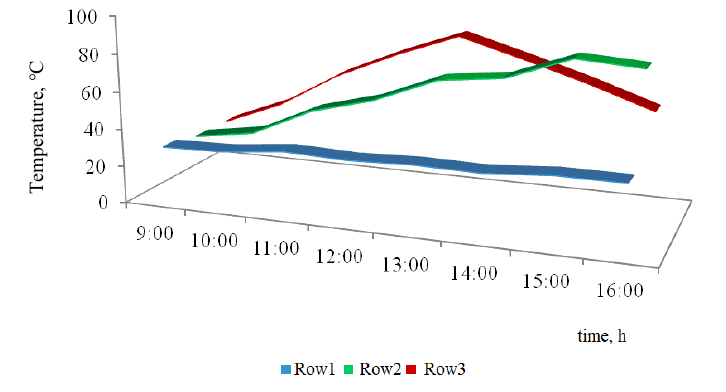
Fig. 5. Oil-containing wastes temperature changes with various sources of